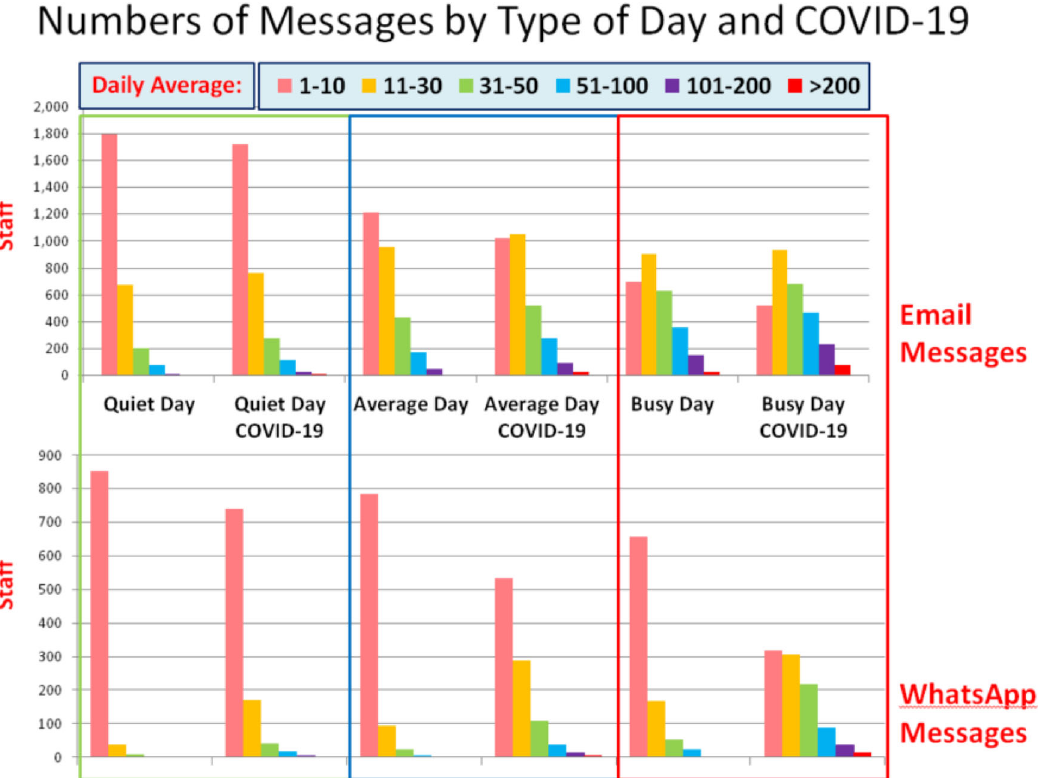
Fig. 3 Figure pertaining to data collected from survey Section 2, showing daily average communication volume estimates, before and during COVID-19, by leading platforms — email and